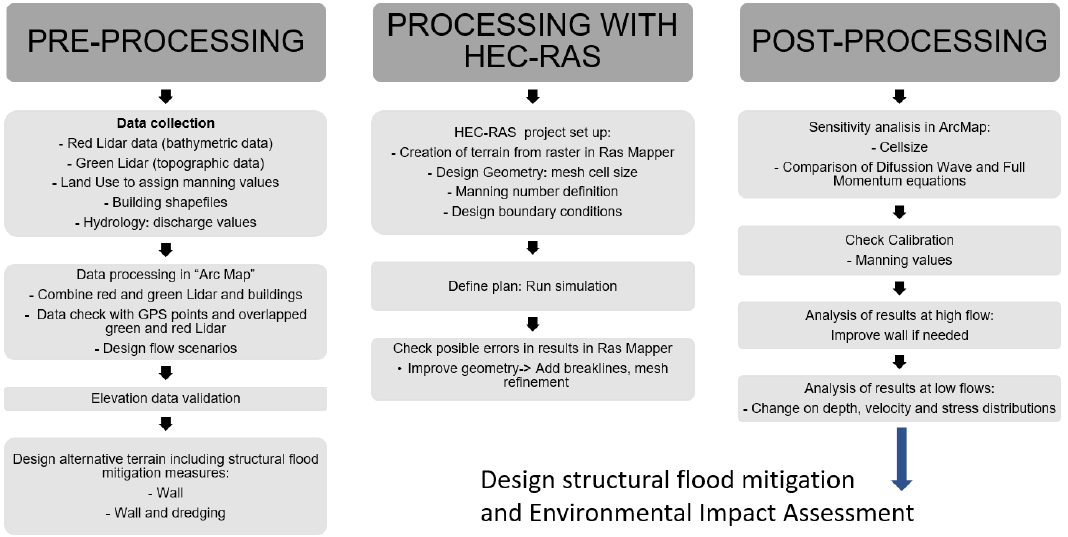
Figure 2. Workflow scheme of the methodology applied including pre-processing, processing with HEC-RAS, and post- processing.